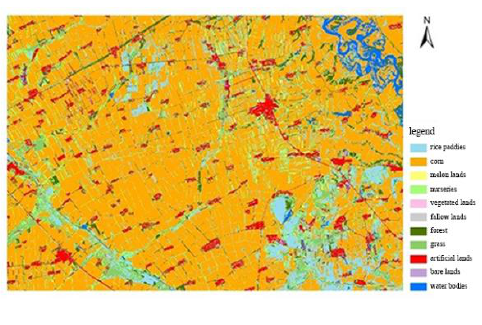
Figure 2. The classification map using AdaTree.